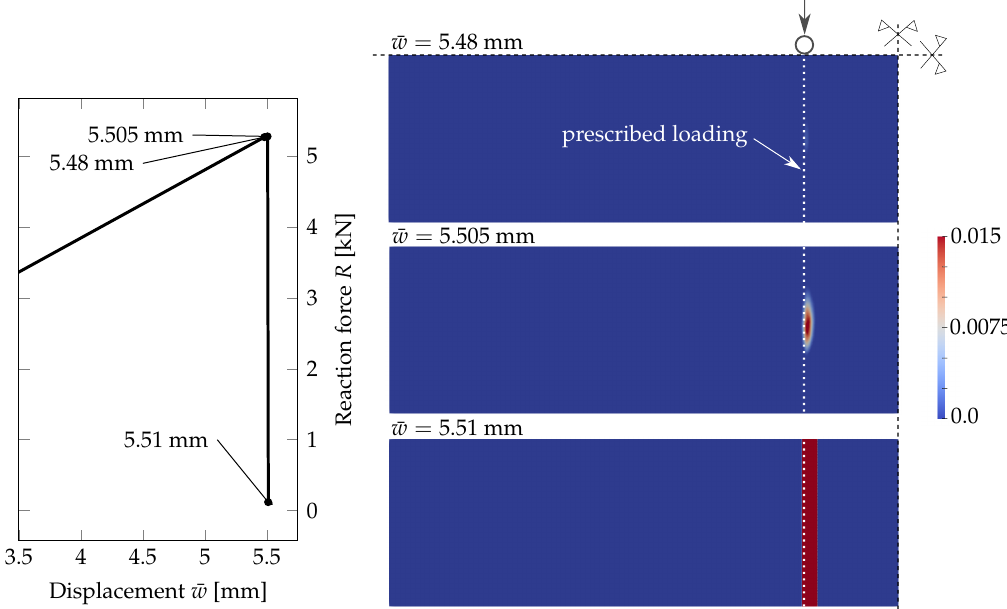
Figure 11. PF-P formulation, anisotropic staggered approach with the spectral-decomposition split: Evolution of the phase-field parameter on a quarter of the glass plate.